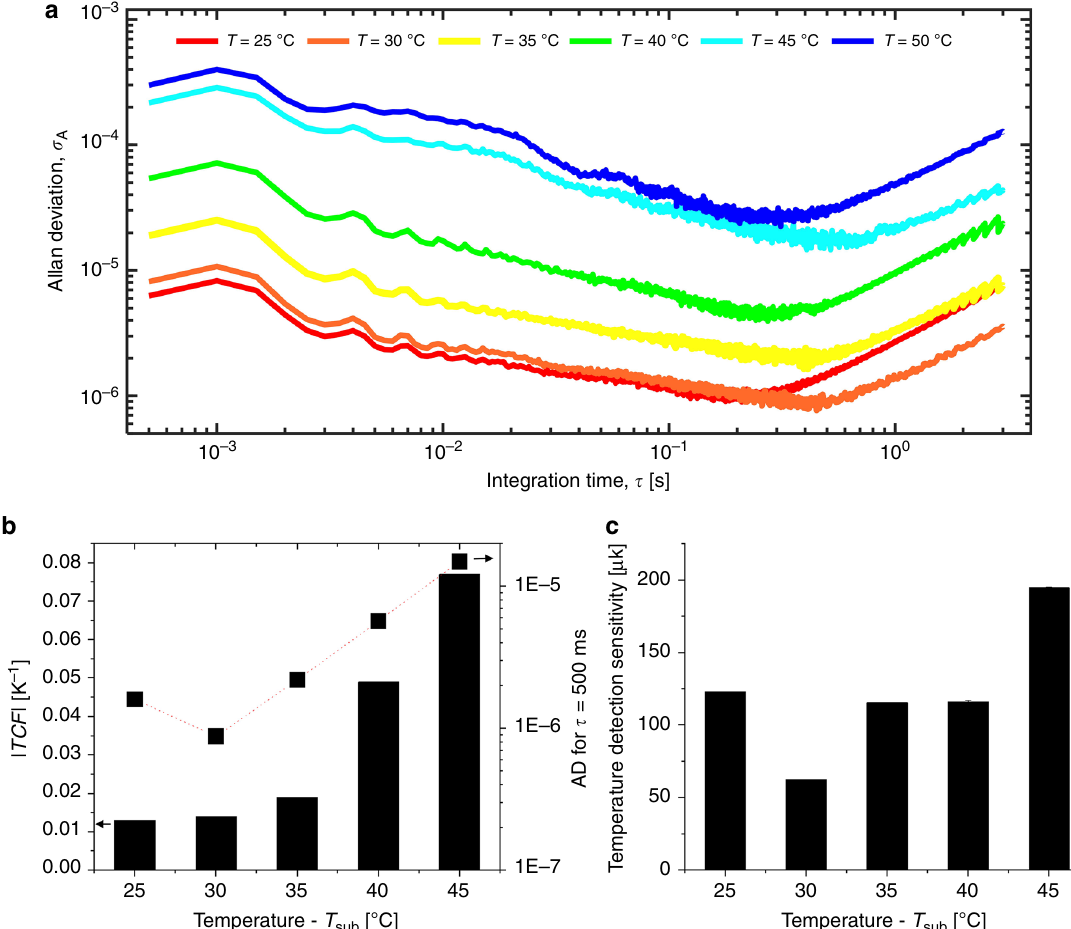
Fig. 3 TCF, frequency stability and sensitivity analysis for the SMP resonator. a Allan Deviation measurements as a function of integration time for different operation temperatures obtained in vacuum (~10 – 3 Pa). b TCF (left y -axis) and AD measurement (right y -axis) for an integration time of τ = 500 ms vs. operation temperature ( T sub ). c Computed temperature detection sensitivity ( δ T